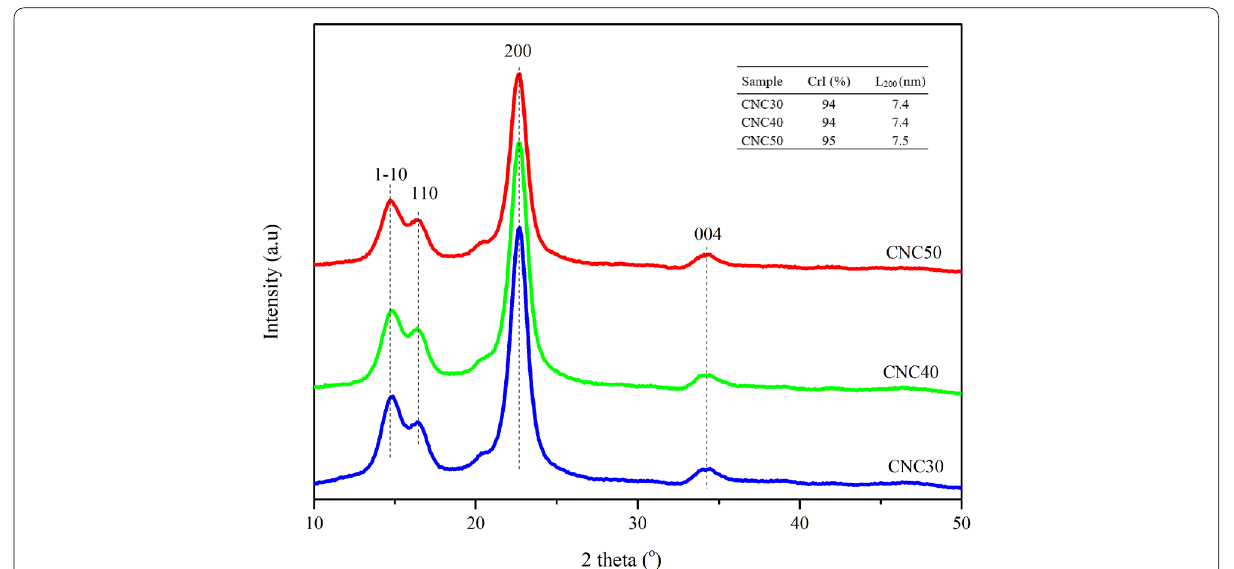
Fig. 5 XRD patterns, crystallinity index and crystallite size of CNC30, CNC40, and